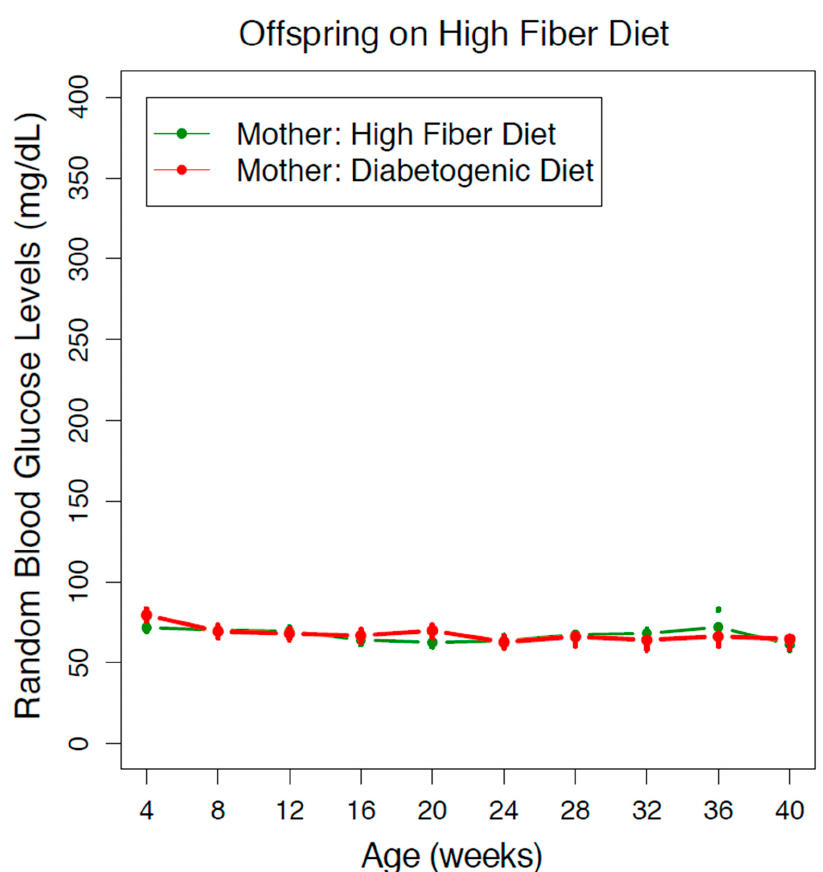
Figure 2. Maternal diet does not influence offspring on a high-fiber diet. The progression of diabetes in the Nile rat offspring (both sexes) fed a high-fiber diet is depicted as a series of random blood glucose levels from 4 to 40 weeks old. When the offspring were fed a high-fiber diet, they did not develop diabetes from mothers with a high-fiber diet or from mothers with a diabetogenic diet. The error bars reflect a 95% confidence interval of the data. The number of Nile rats: n = 131 (green), n = 90 (red).